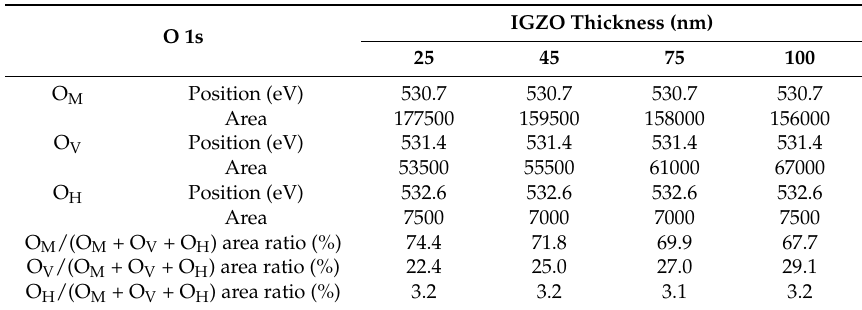
Figure 2. X-ray photoelectron spectroscopy (XPS) spectra of O 1s peaks of the IGZO films with the thickness of ( a ) 25 nm; ( b ) 45 nm; ( c ) 75 nm; and ( d ) 100 nm, respectively. Table 1. The position, areas, and area ratios of the deconvoluted O 1s peaks for the IGZO films with various